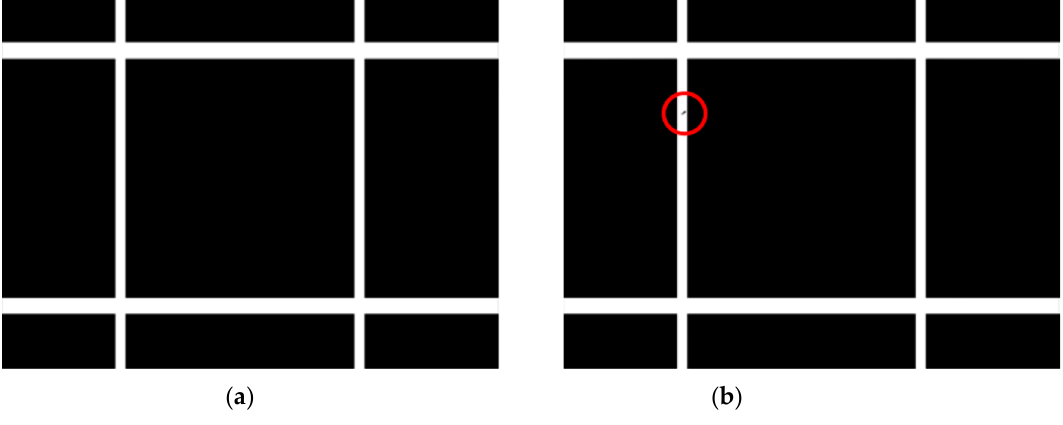
Figure 9. ( a ) The mask for the intervals. ( b ) The image of the intervals segmented using the mask in ( a ) and the defect is marked with a red circle.